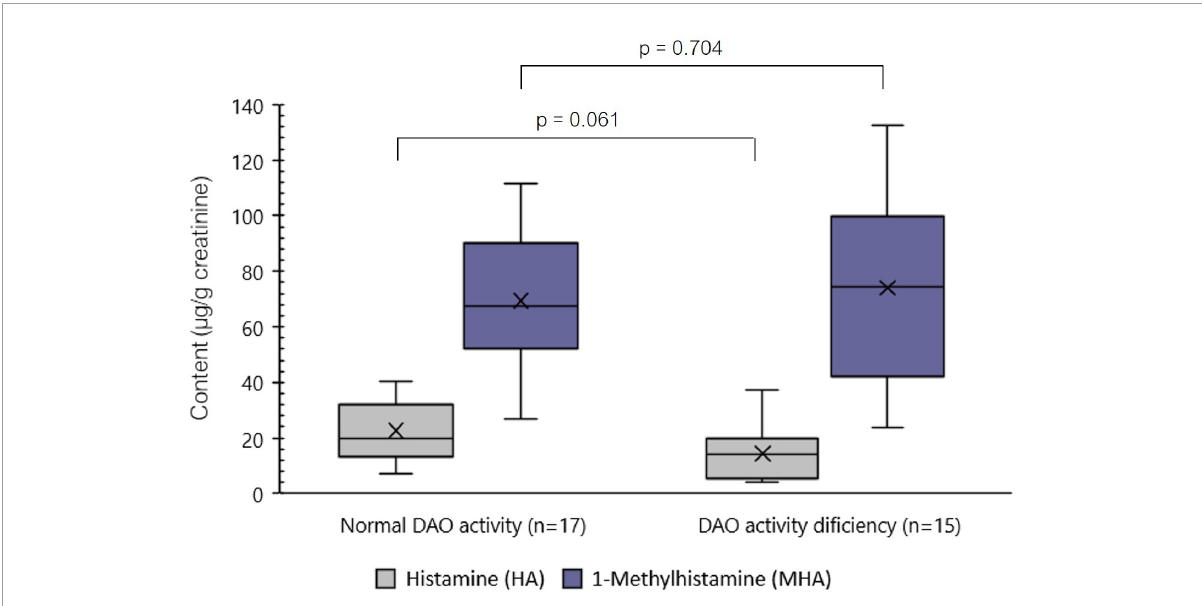
FIGURE3 Distribution of the levels ( µ g/g creatinine) of histamine (HA) and 1-methylhistamine (MHA) in spot urine samples of individuals with symptoms of histamine intolerance with or without serum DAO enzyme deficiency. p < 0.05 indicates statically significant differences in the urinary content of the analytes between study groups.